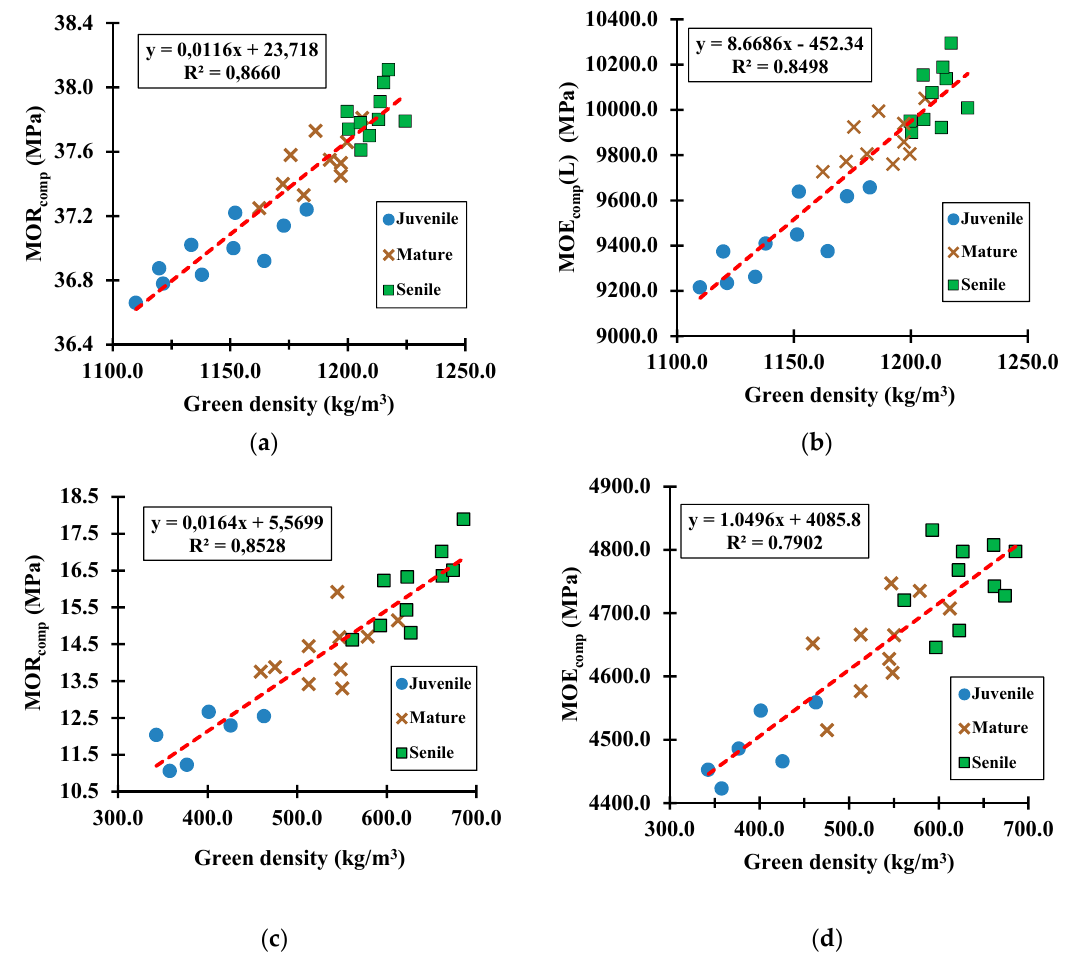
Figure 10. Green samples tested under the compression mode to determine the relationship of green density versus ( a ) MOR for eucalyptus species, ( b ) MOE for eucalyptus species, ( c ) MOR for cypress species, and ( d ) MOE for cypress species.